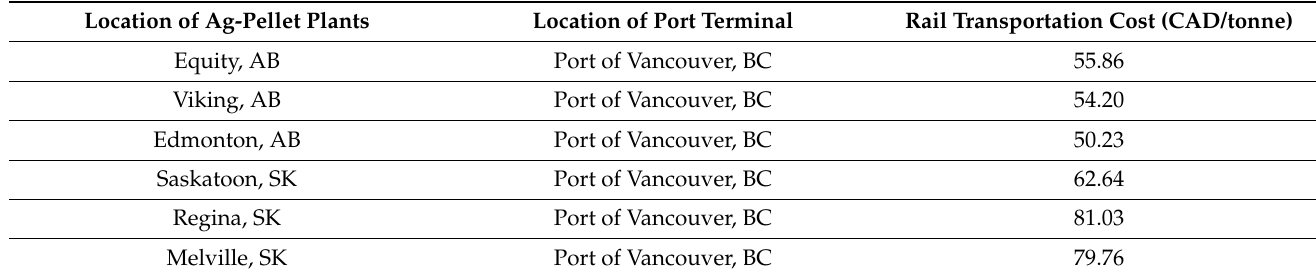
Table 4. Rail transportation cost of ag-pellets from the pellet plants to the Port of Vancouver. Location of Ag-Pellet Plants